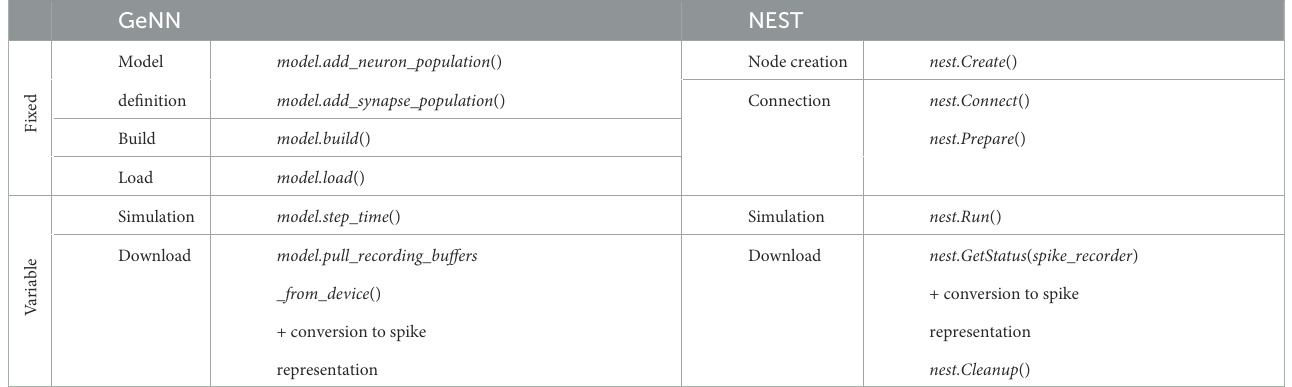
TABLE 8 Execution phases of